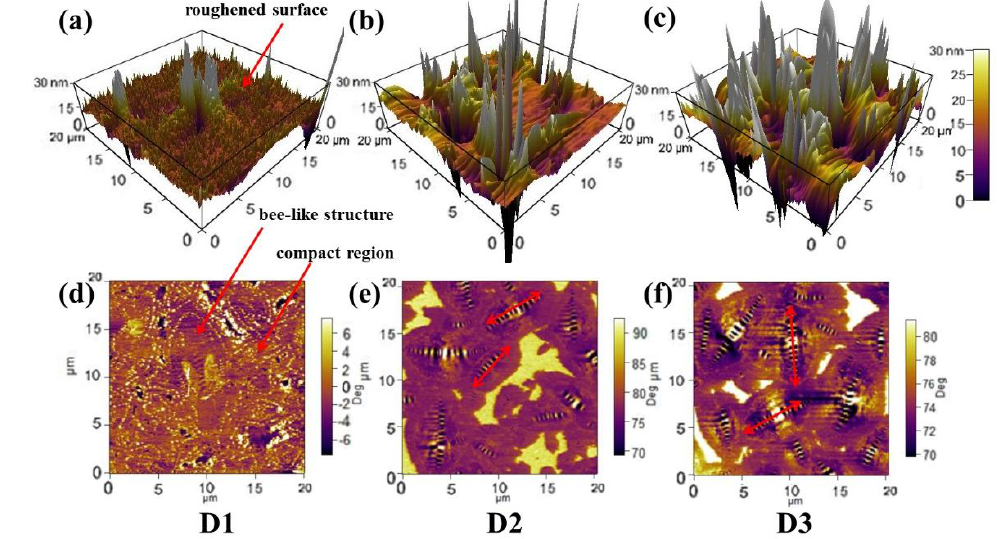
Figure 6. AFM images for the MR-1 rejuvenated sample: ( a ) 3D height images of D1 slices; ( b ) 3D height images of D2 slices; ( c ) 3D height images of D3 slices; ( d ) phase images of D1 slices; ( e ) phase images of D2 slices; ( f ) phase images of D3 slices.